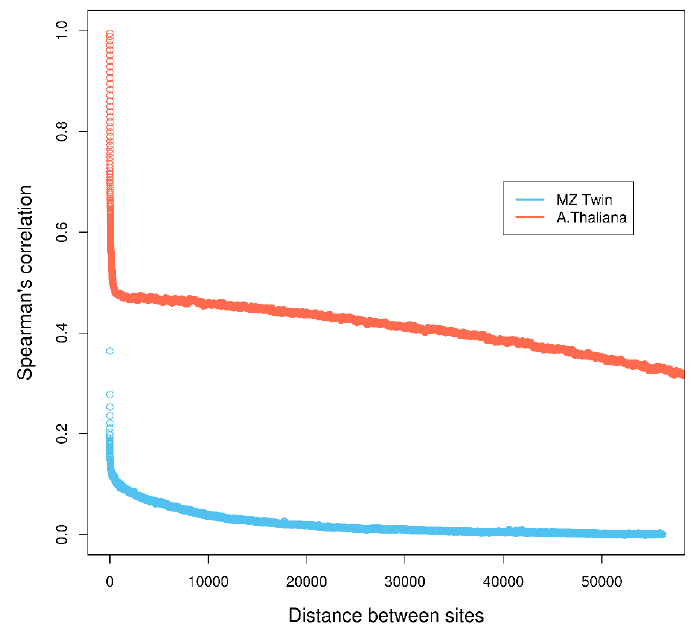
Figure 1. Correlation of methylation levels of neighboring cytosine regions in monozygotic (MZ) twin and neighboring cytosines in Arabidopsis thaliana datasets. Details of the calculation are in Section 1 in Supplementary Materials.